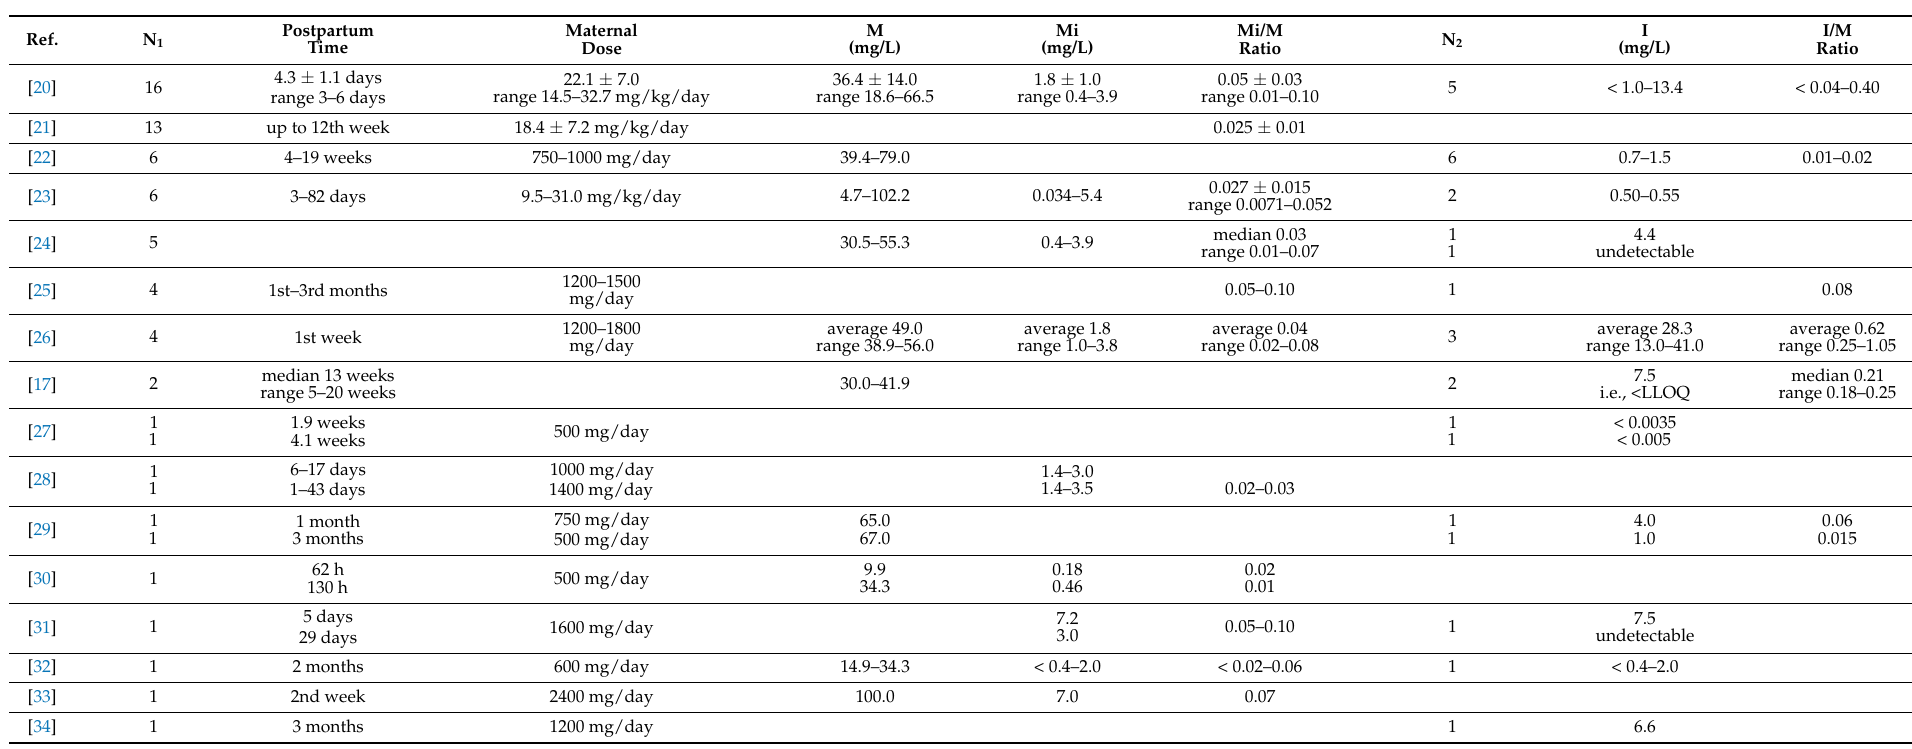
Table 4. Review of literature; Ref = reference, N 1 = number of mothers, N 2 = number of breastfed infants, M = maternal, Mi = milk, I = infant concentrations [17,20–34].